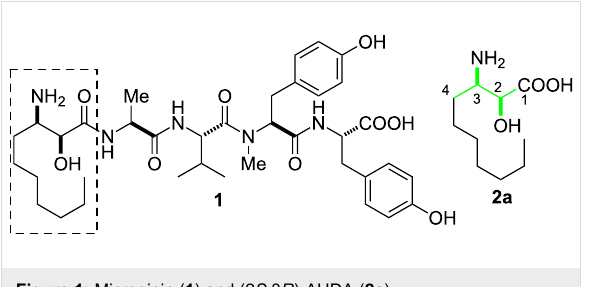
Figure 1: Microginin ( 1 ) and (2 S ,3 R )-AHDA ( 2a